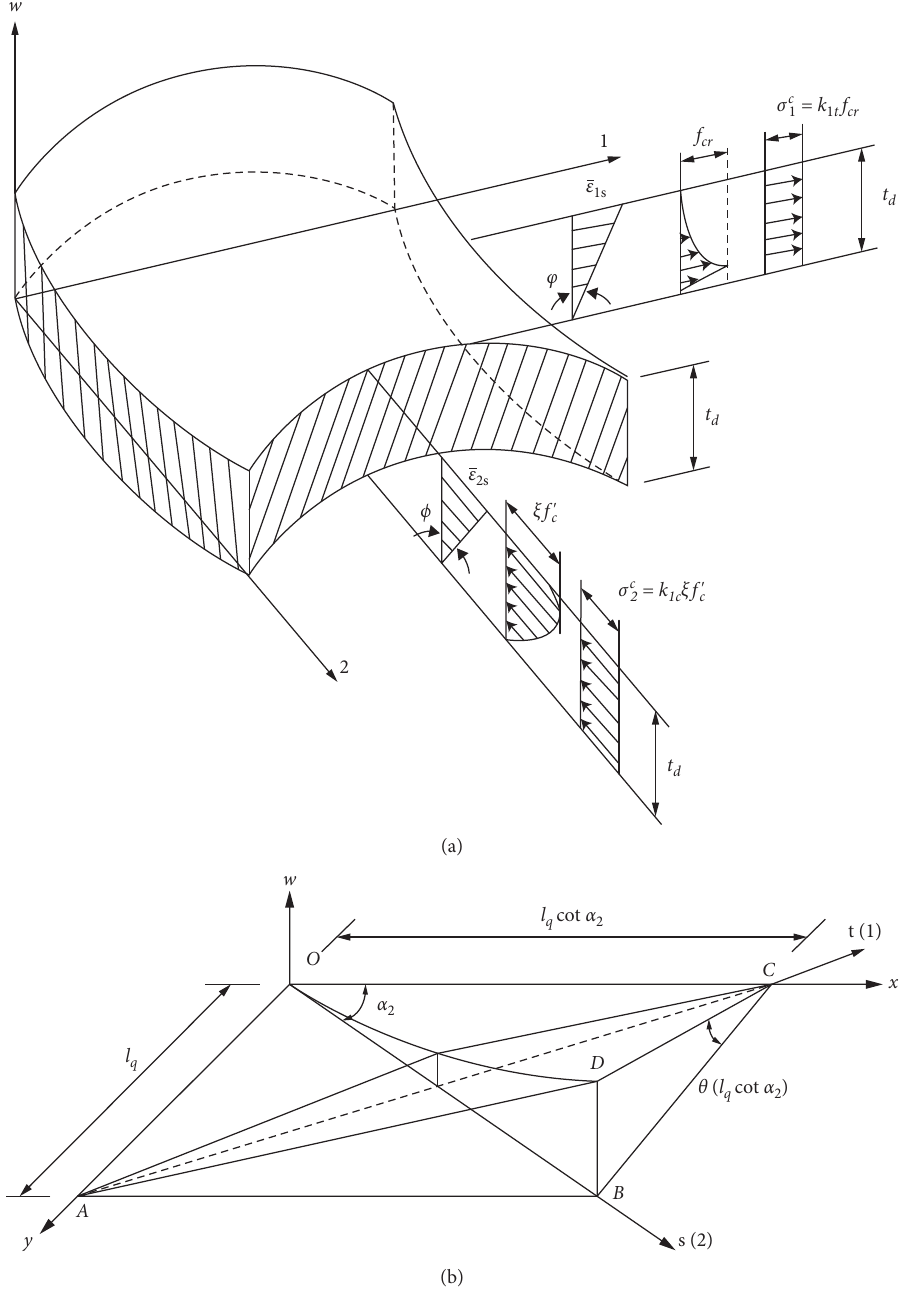
Figure 2: Concrete strut bending: (a) biaxial stress state without plane bending and (b) hyperbolic paraboloid surface for out-of-plane bending.